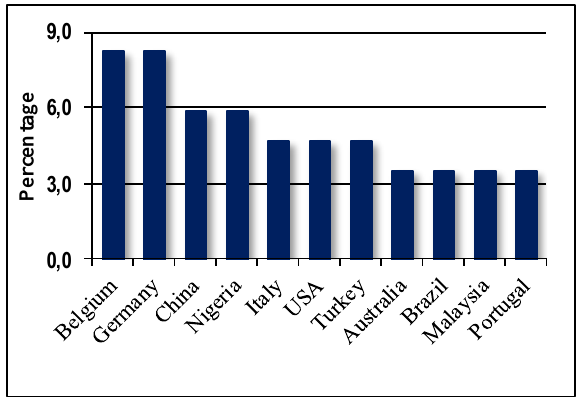
Figure 8. Countries making major contribution in implementation and research related to Applied Geodesy: Figure 4. Countries making major contribution in professional standards and practices, tools and implementation and research related to Laser scanning: techniques and applications, 3D modelling, remote sensing, BIM